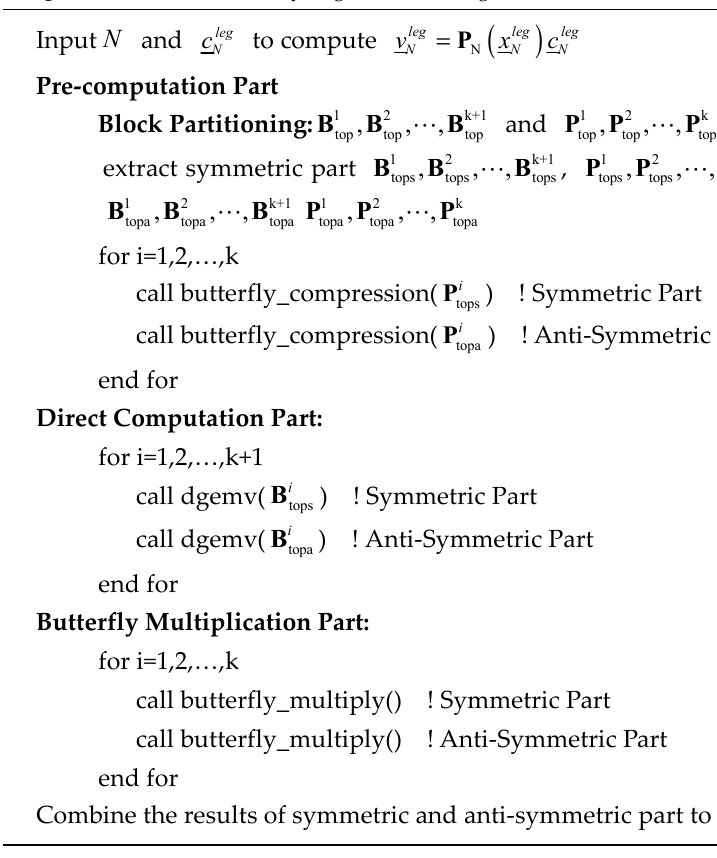
Figure 2. Block butterfly algorithm for Legendre